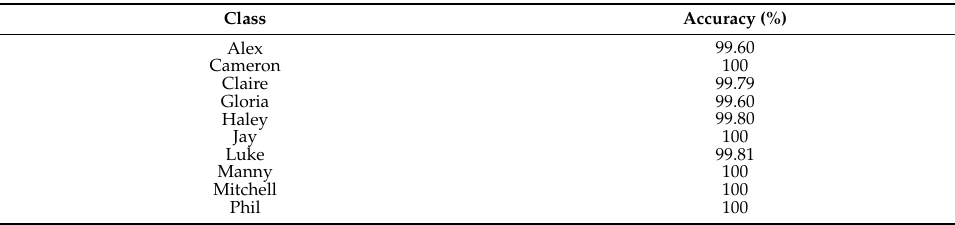
Table 3. The accuracy of each class in the test set in the Advanced CNN model.